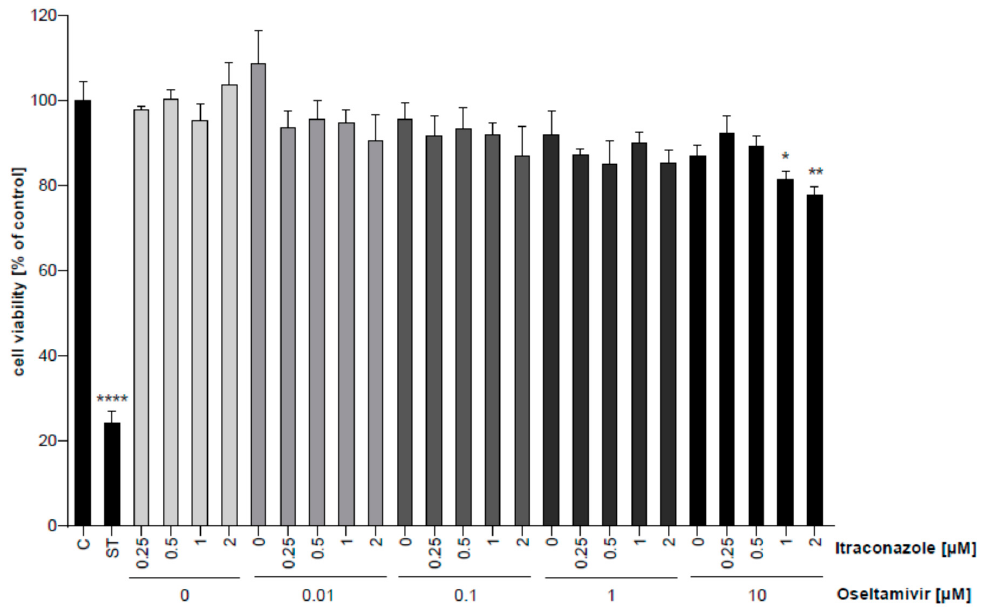
Figure 2. Analysis of the cytotoxicity of oseltamivir and itraconazole in single or combinatory treatment. Polarized Calu-3 monolayers were treated at the indicated concentrations with oseltamivir, itraconazole, or combinations for 24 h. Data represent mean percentages of viable cells ± SEM, with mean viability in control cells treated with the solvent DMSO (C) set to 100%. Cell death induced by staurosporine (ST) served as a positive control. n = 3, one-way ANOVA followed by Dunnett’s multiple comparison test. * p < 0.05, ** p < 0.01, **** p < 0.0001. To confirm the anti-IAV activity of both drugs, the polarized monolayers were inoculated with 0.1 MOI of either pdm09 or Panama isolate, and the drugs were added 2 h p.i. Both IAV subtypes